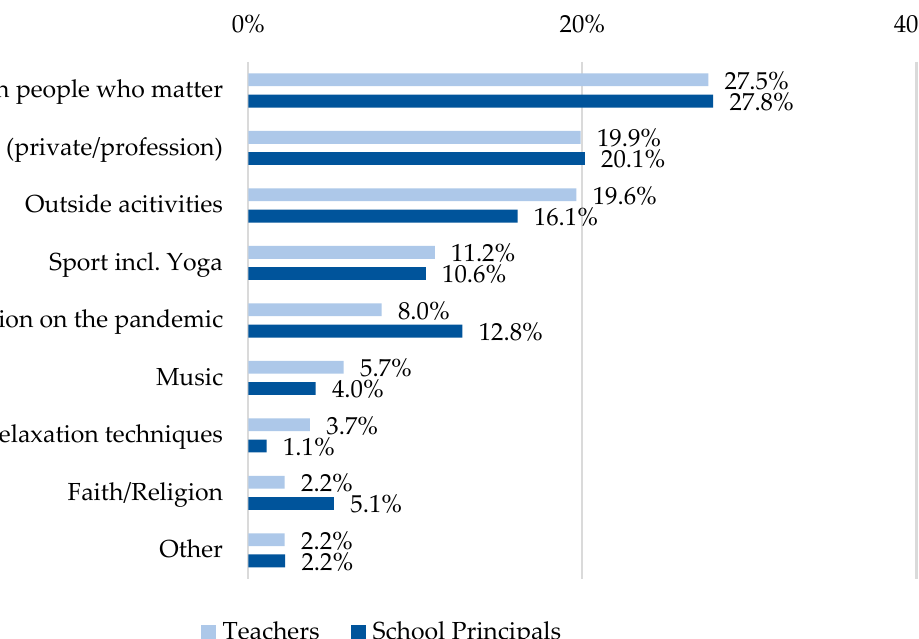
Figure 2. Who do you feel supported by during the pandemic? (Multiple answers possible).